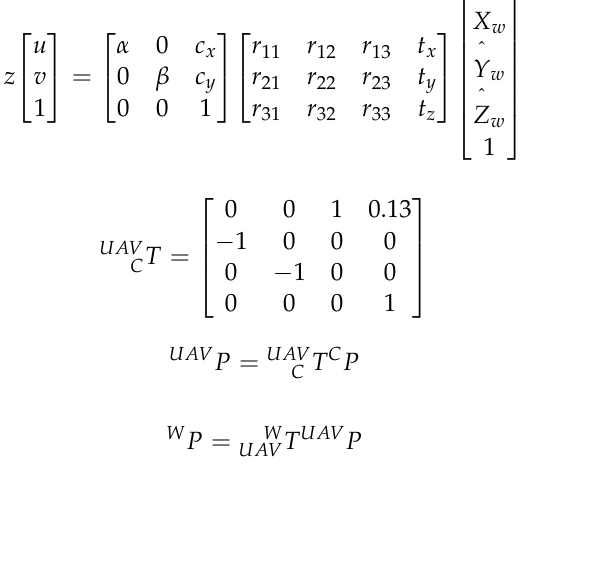
Figure 11. 3D-to-2D forward projection.